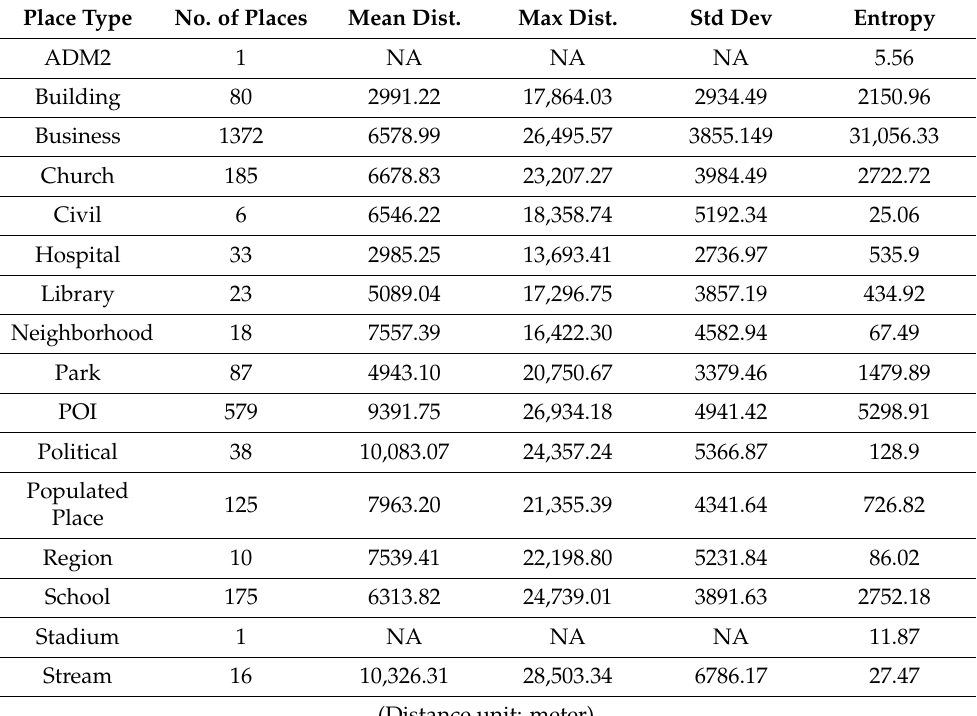
Table 1. Summary of statistical features of place categories in Athens, GA, USA. Place